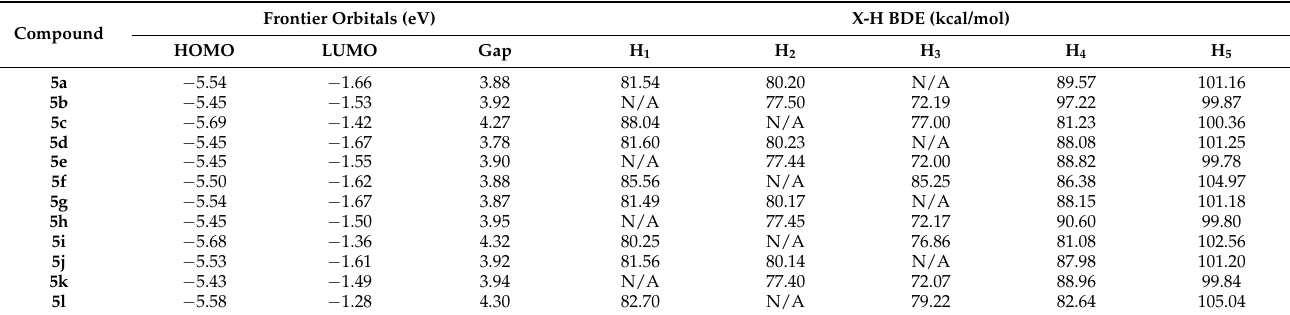
Table 7. The energy of the frontier orbitals and the BDE for the H 1 –H 5 sites in the studied compounds, according to the numeration presented in Figure